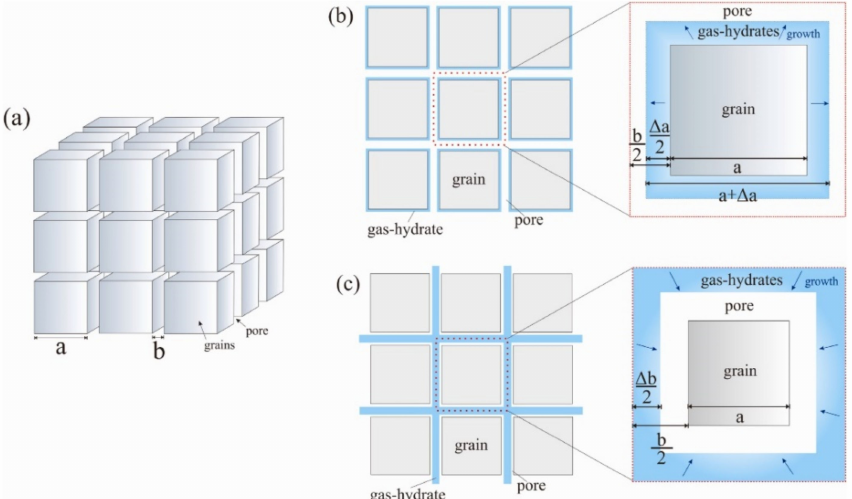
Figure 29. Geometry scheme of the Cubic model for GC and PF hydrate reprinted from [72] with permission from Elsevier. ( a ) Pore system and framework of the cubic model; ( b ) pore system changed by GC hydrate; ( c ) pore system changed by PF